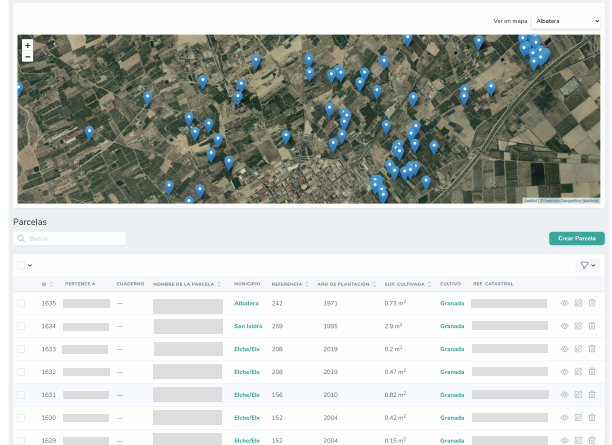
Figure 12. A list of geolocated plots. Personal data has been removed from the image.